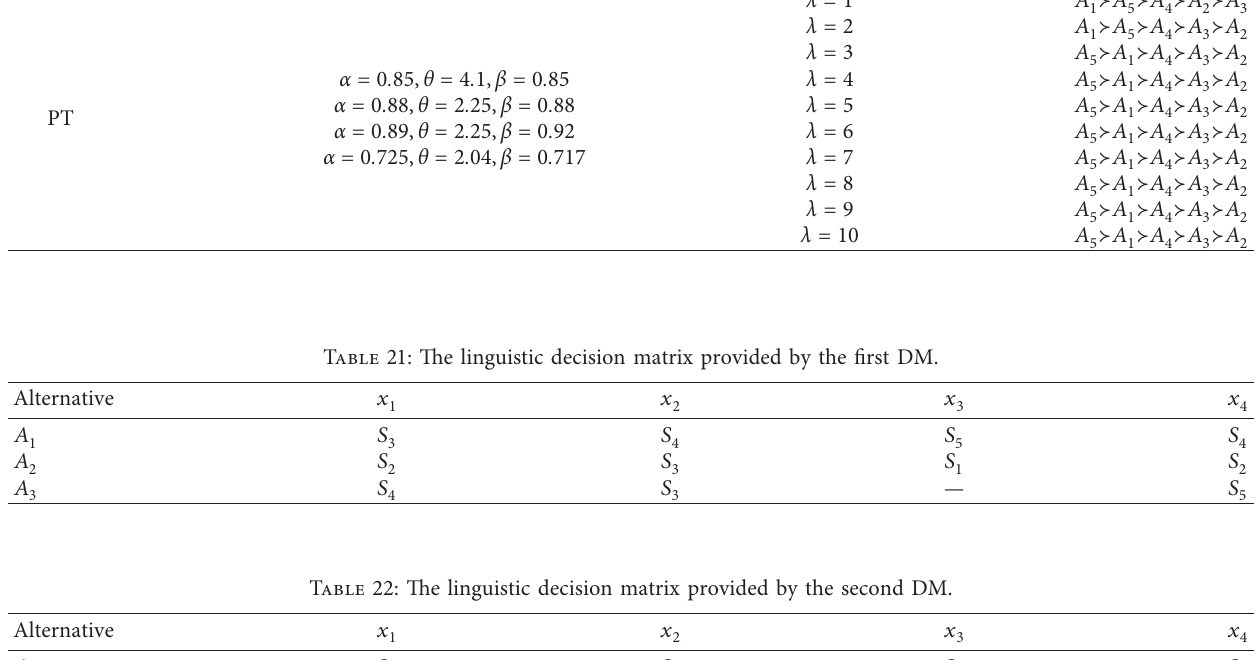
Table 20: The ranking of A